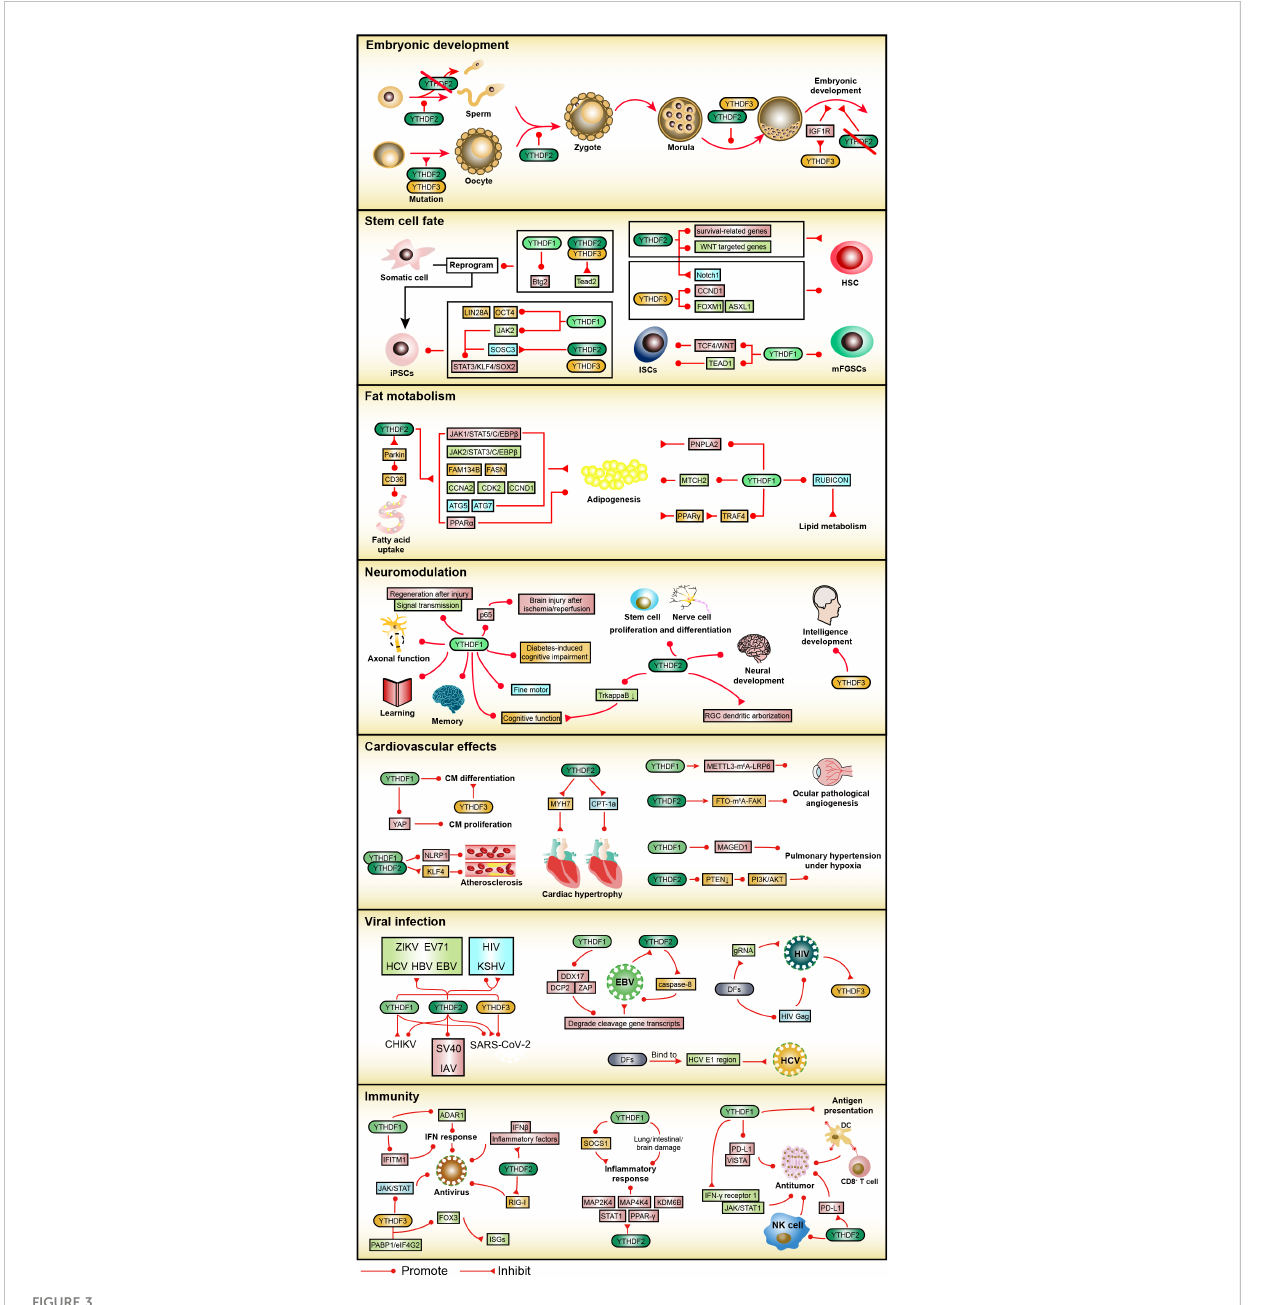
FIGURE 3 The roles of the YTHDF family in embryonic development, stem cell fate, fat metabolism, neuromodulation, cardiovascular effect, viral infection, and immunity. In embryonic development, YTHDF2 is essential for sperm, oocyte, zygote, and embryo formation. In stem cell fate, the YTHDF family promotes somatic cell reprogramming and the properties of iPSCs. In addition, YTHDF2 and YTHDF3 participate in the fate of HSC, and YTHDF1 in the fate of ISCs as well as mFGSCs. In fat metabolism, YTHDF1 and YTHDF2 regulate adipogenesis and fatty acid metabolism. In neuromodulation, YTHDF1 affects axonal function as well as learning and memory, YTHDF2 regulates neural development and differentiation, and YTHDF3 participates in intellectual development. In cardiovascular effect, YTHDF1 and YTHDF2 are closely related to the fate of CM, vascular endothelial cells, and pulmonary artery smooth muscle cells. In a viral infection, the YTHDF family is involved in the life cycle of several viruses, especially EBV, HCV, and HIV. In immunity, the YTHDF family plays an important role in antiviral immunity, in fl ammatory immunity, and anti-tumor